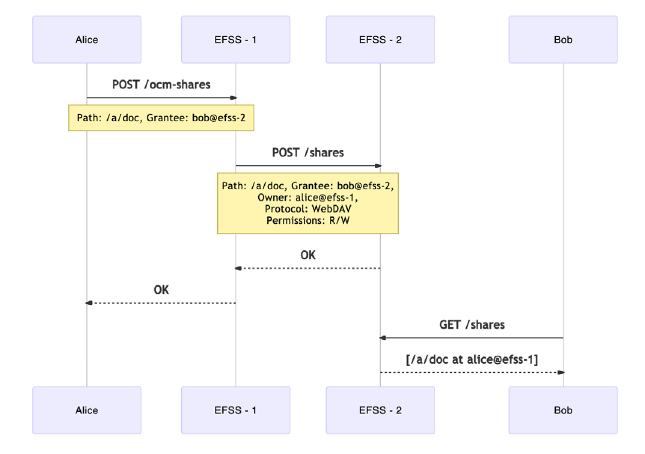
Figure 1. OCM Share workflow across providers in